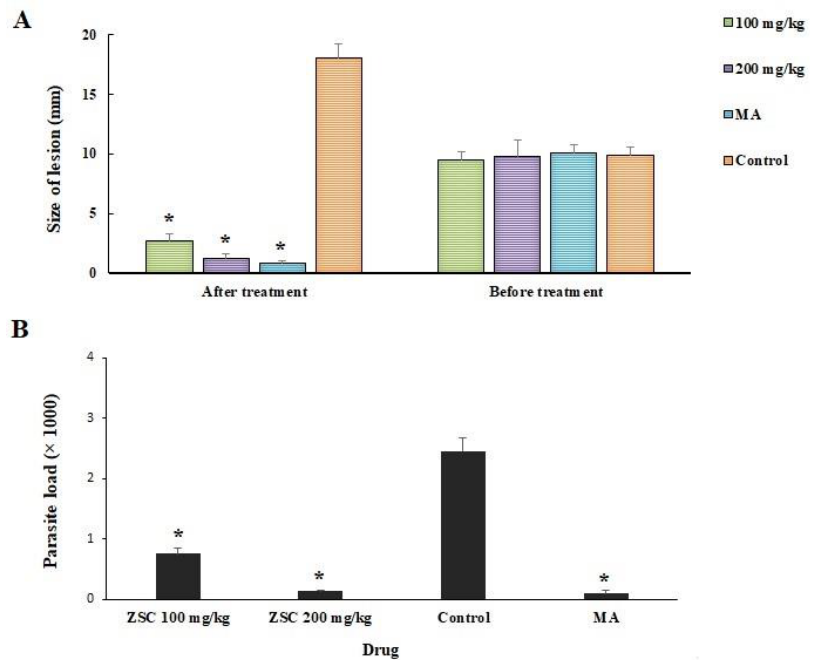
Figure 2. ( A ) Antileishmanial effects of Z. spina-christi extract on the size of lesions in BALB/c mice infected by L. major . * p < 0.001 compared with the control group; ( B ) Comparison of mean number of parasites (parasite load) in infected mice after treatment with various concentrations of Z. spina-christi extract compared with control group. * p < 0.001.